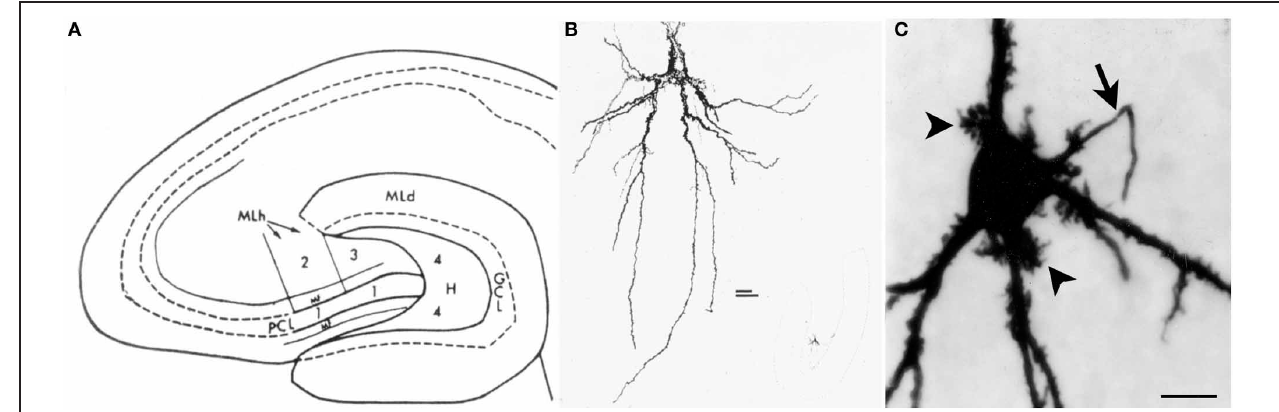
FIGURE 1 | Introduction to the hilus and mossy cells. (A) A schematic of the rat hippocampus from Amaral (1978) in horizontal section shows the location of the hilus (zone 4). GCL, granule cell layer; H, hilus; ML, molecular layer; MF, mossy fiber; PCL, pyramidal cell layer. (B) A drawing of a mossy